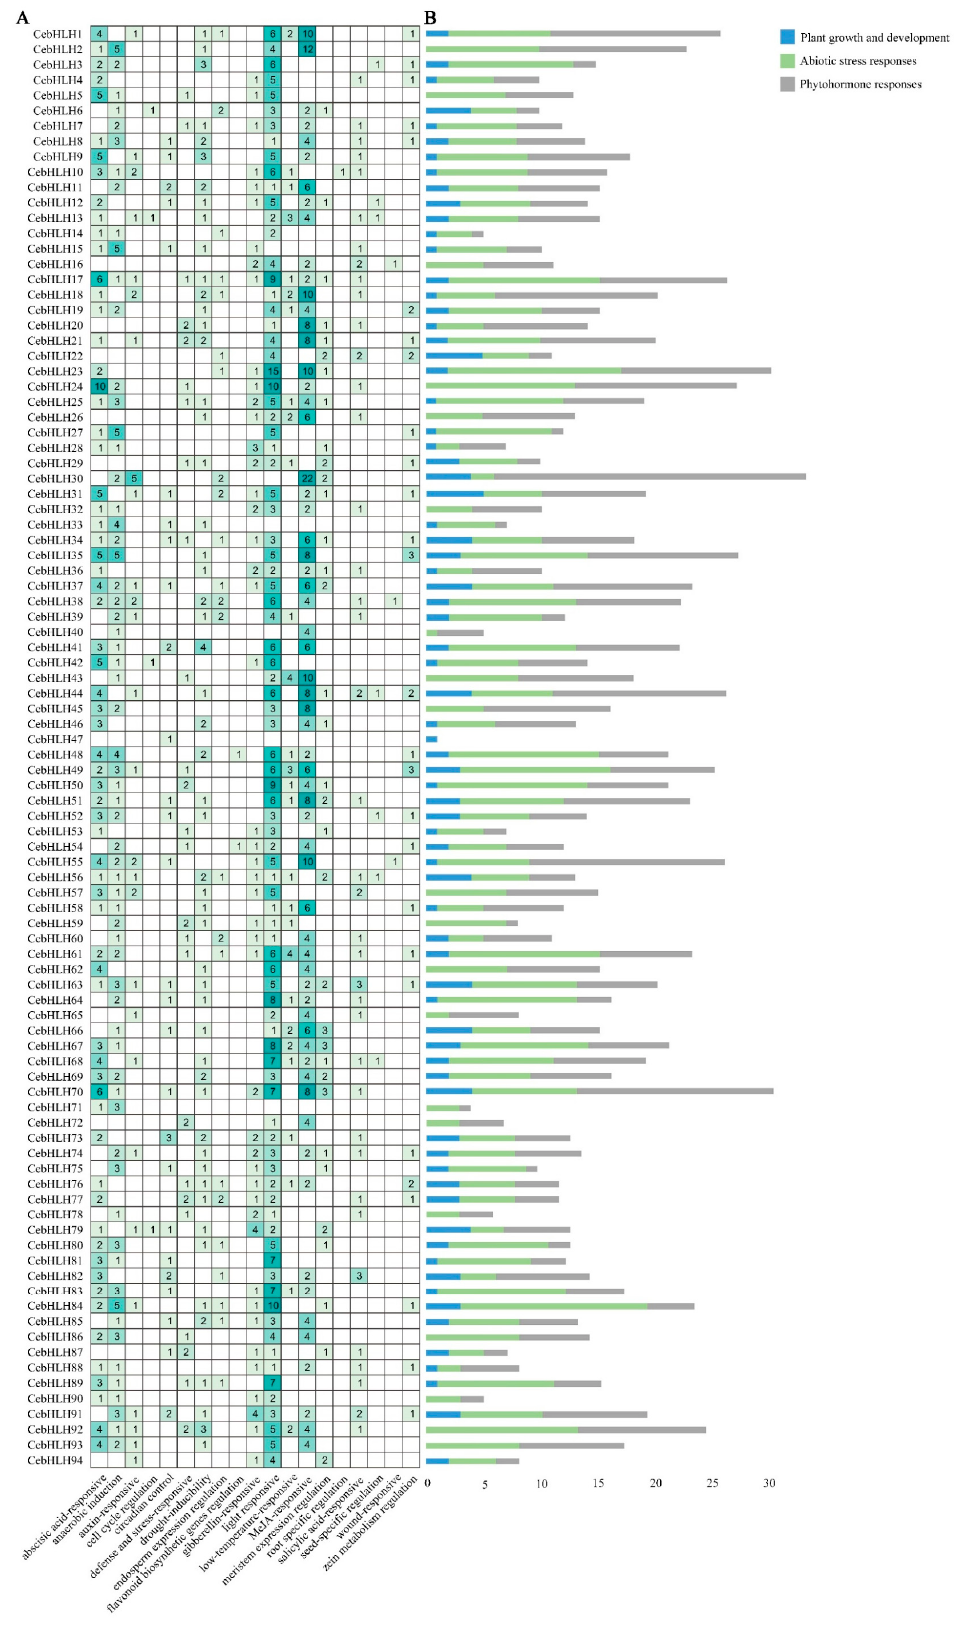
Figure 4. Cis-acting elements of CebHLHs . ( A ) Number of cis-acting elements in CebHLHs . ( B ) Blue, green, and gray colors represent the respective three major categories of cis-acting elements.